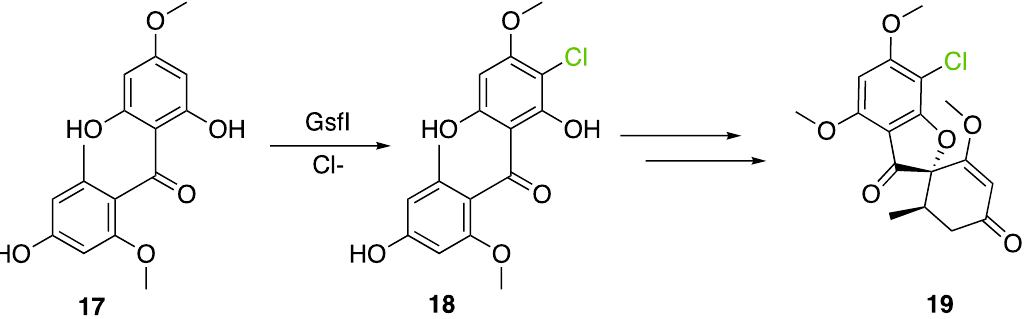
Figure 16. Chlorination of griseophenone C ( 17 ) by GsfI to form griseophenone B ( 18 ), precursor of griseofulvin ( 19 ) in P. aethiopicum.